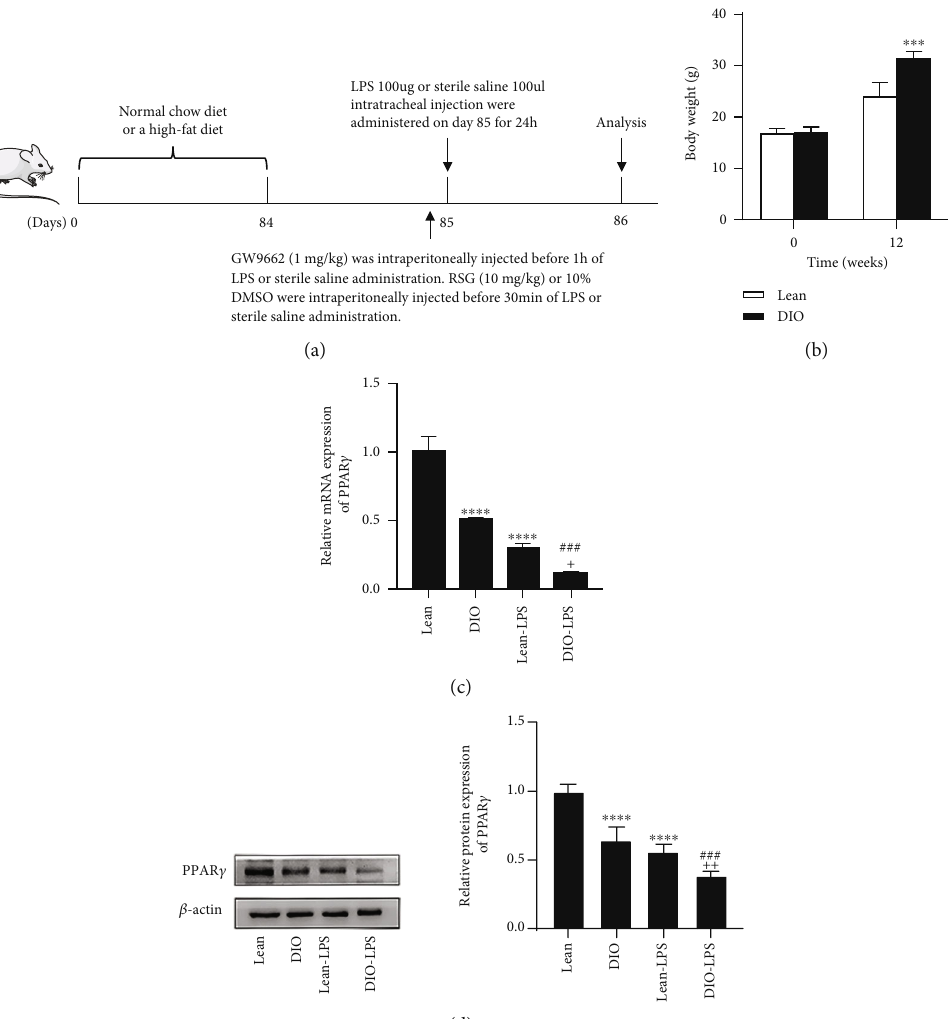
Figure 1: PPAR γ expression was decreased in the lung tissue of obese mice. (a) Schematic diagram of experimental protocol, (b) Body weight of C57BL/6 J mice fed with either high fat diet or normal diet for 12 weeks, (c) Relative mRNA expression of PPAR γ . (d) Western blotting and relative protein expression of PPAR γ . Data are presented as mean ± SD . ∗∗∗ p < 0 : 001 , ∗∗∗∗ p < 0 : 0001 vs. Lean, ### p < 0 : 001 vs. DIO, + p < 0 : 05 , ++ p < 0 : 01 vs.